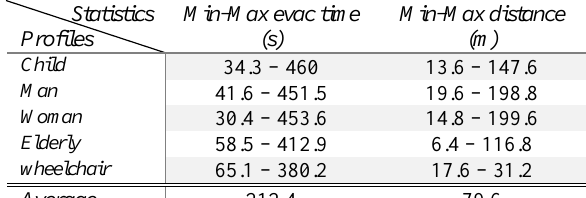
Table 4. Results of Steering mode.